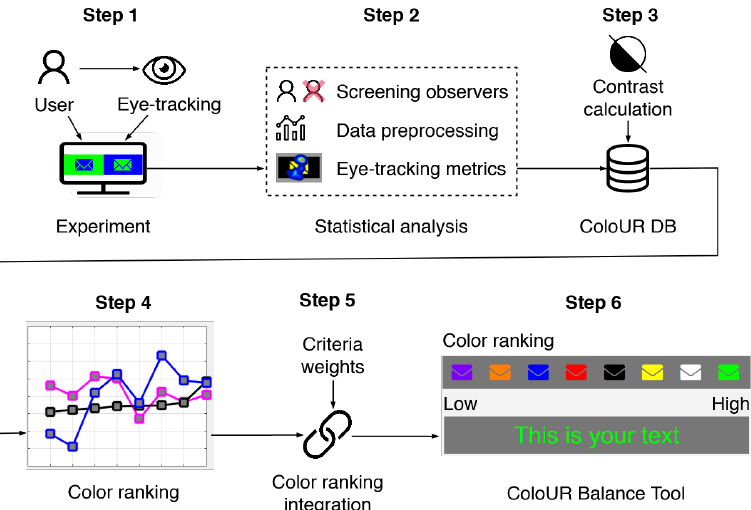
Figure 5. The schema shows the research procedure. The experiment with user participation allowed us to collect data on the time to first fixation for color pairs. The collected data were subjected to statistical analysis, resulting in the formation of the ColoUR DB. The ColoUR DB contains data on the natural eye fixation of users on color pairs and a contrast calculation for the same color pairs. Color ranking is based on parameters entered by the designer, i.e., criteria and their weights. The ranking can be generated for each criterion or in an integrated form. The research result is a tool for designers—the ColoUR Balance